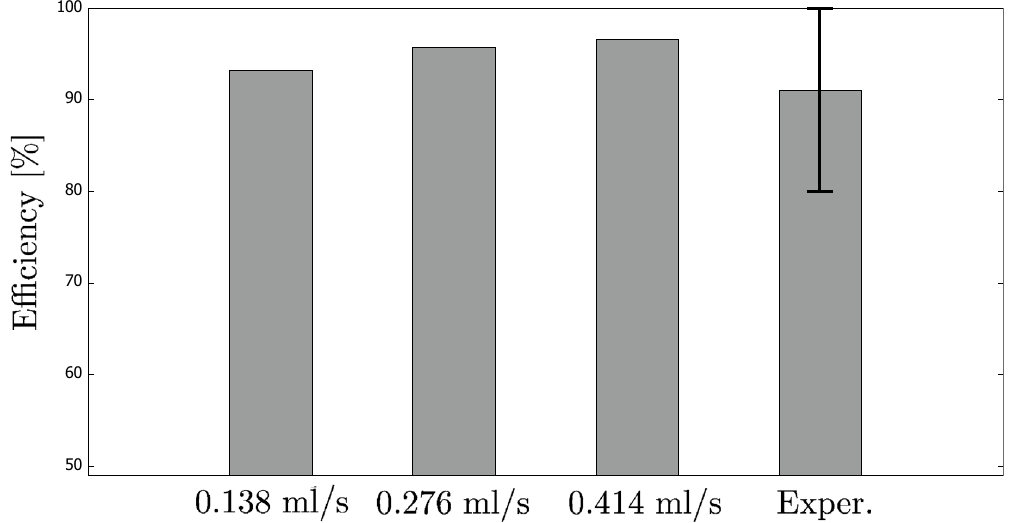
Figure 14. The efficiency calculated using the simplistic model and validated against the experimental results from 17 . The theoretical analysis was performed for three different values of the volumetric flow rate.